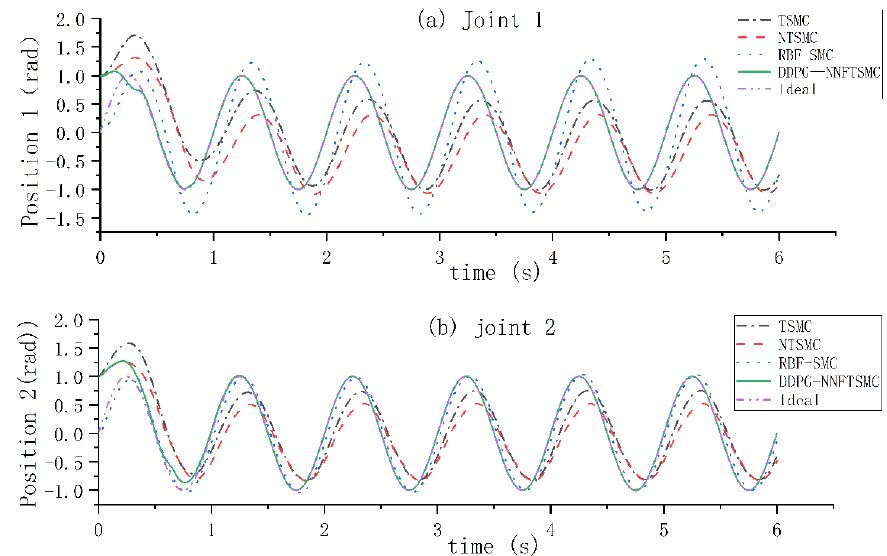
Figure 4. Trajectory tracking positions.